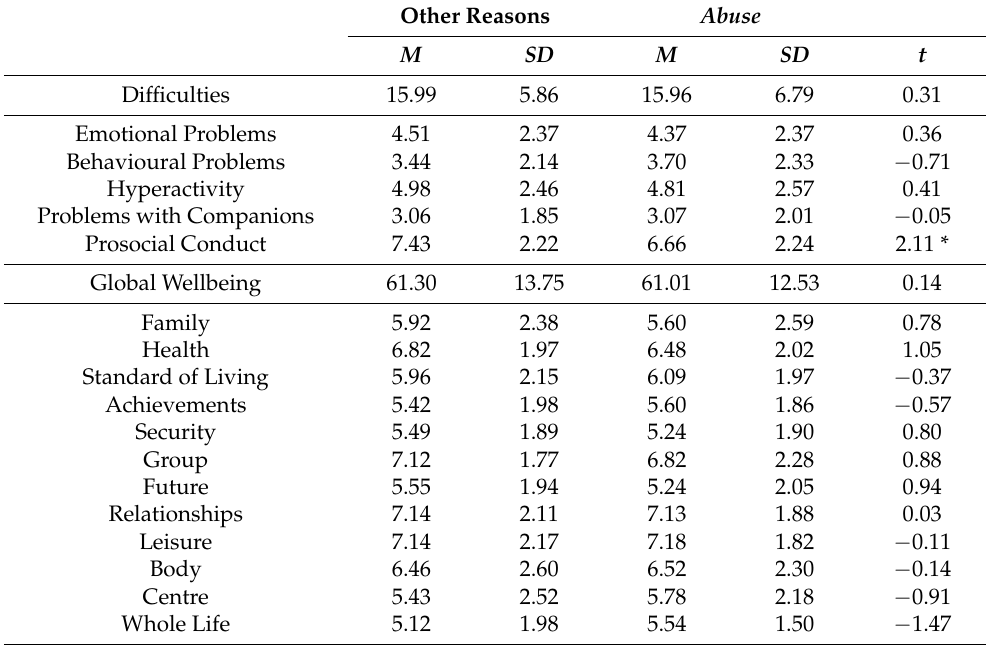
Table 3. Comparison of the means of the difficulties and personal wellbeing according to the reason for the protective